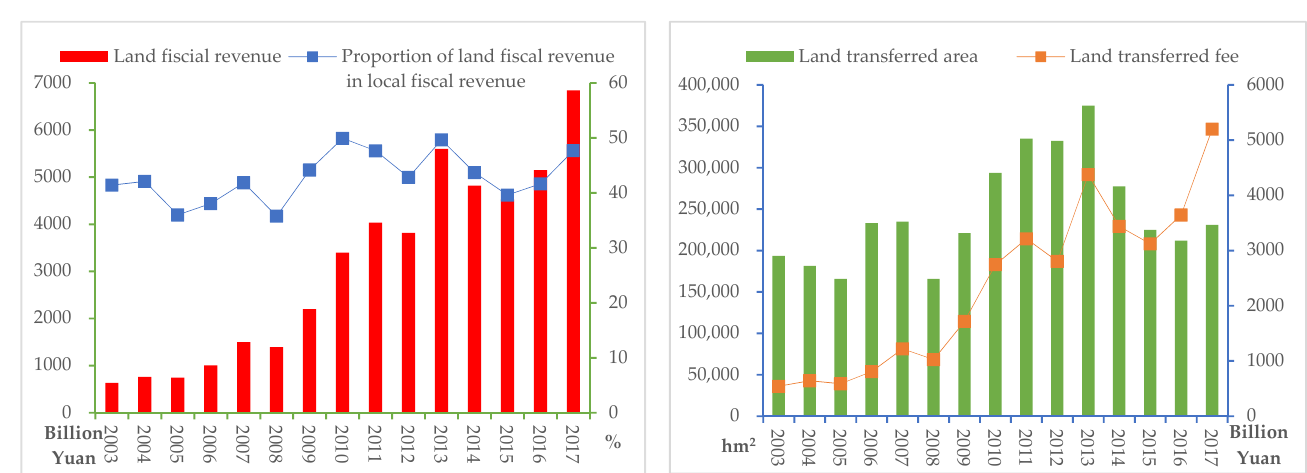
Figure 1. Changes in land finance in China from 2003 to 2017.